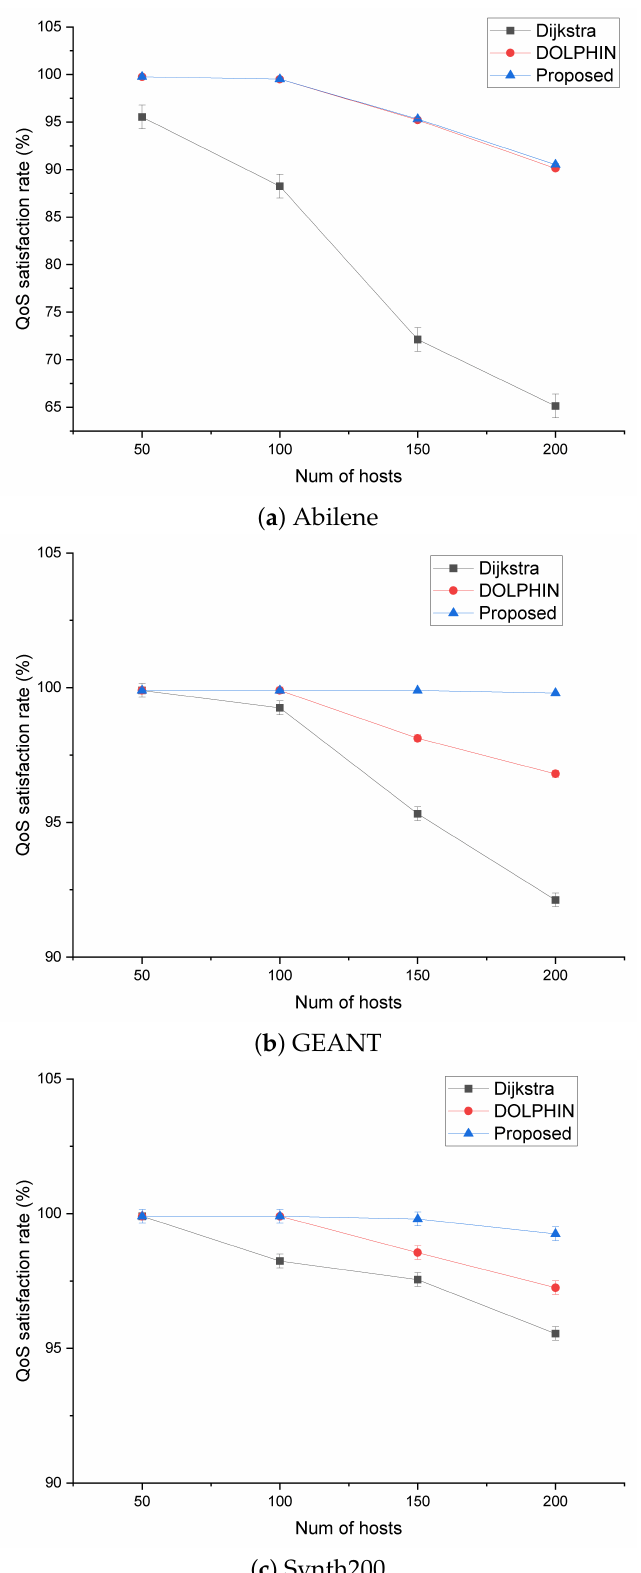
Figure 10. QoS satisfaction rate according to the number of